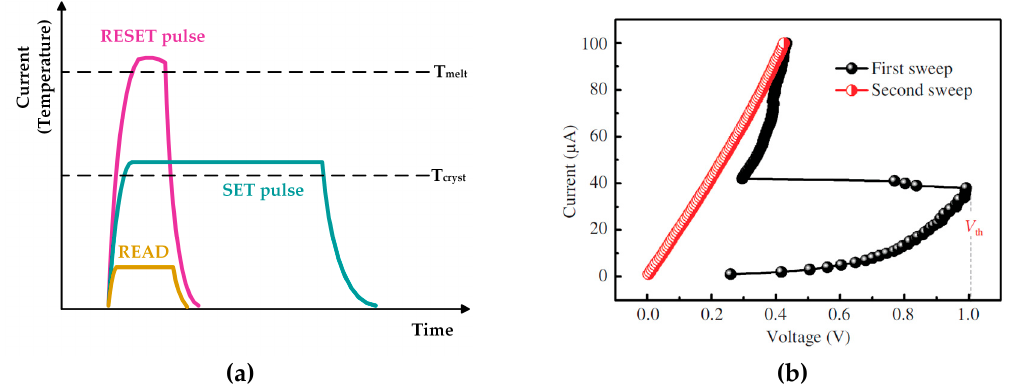
Figure 2. ( a ) Program and read operations of phase change memory (PCM); ( b ) the threshold switching phenomenon of chalcogenide compounds.